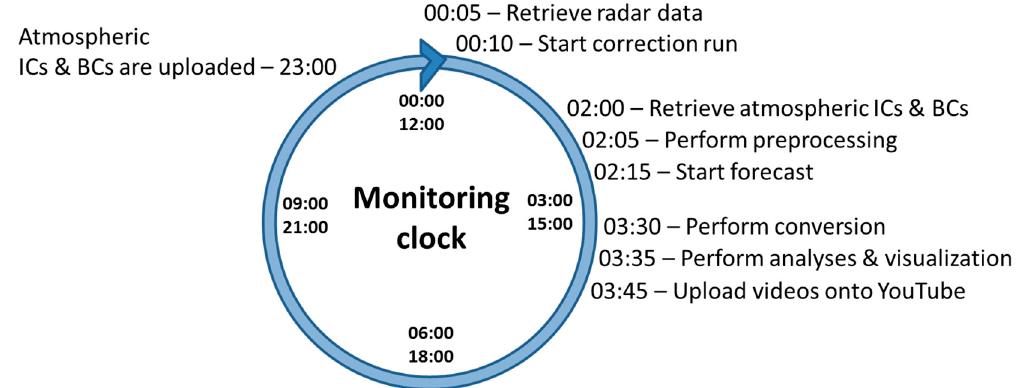
Figure 2. Schematic of the monitoring clock for the NRW and EU domains. Note, the rain radar correction is only performed in case of the NRW domain (ICs: Initial conditions; BCs: Boundary conditions).